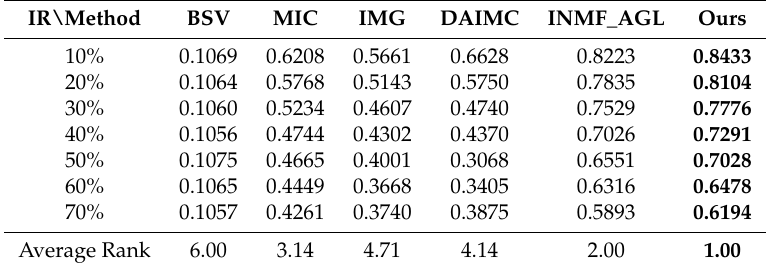
Table 4. ACCs and average ranks on 100Leaves under different incomplete ratios. Bold numbers denote the best result.